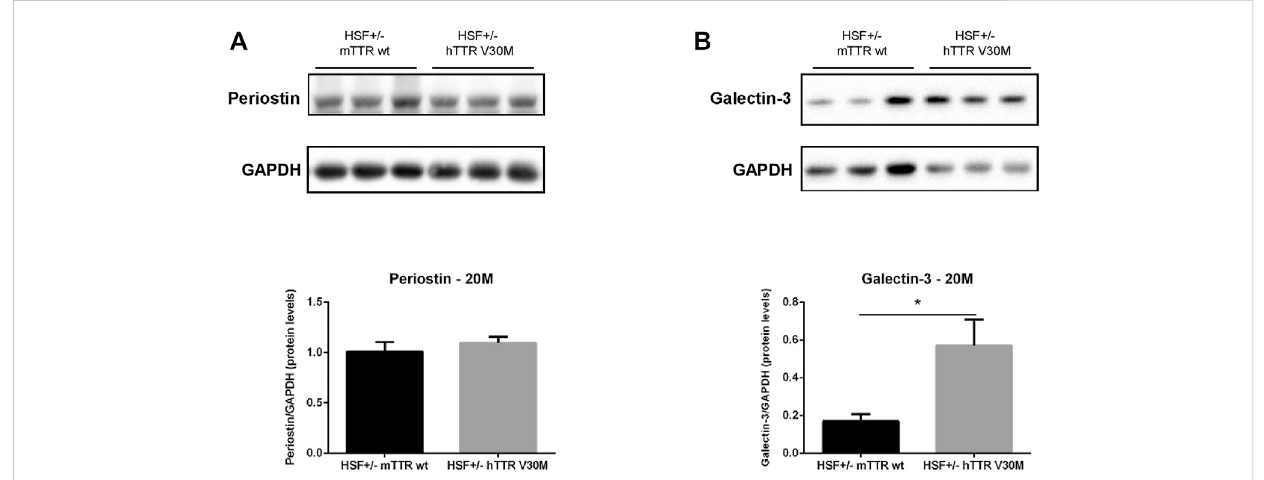
FIGURE 2 Protein levels of relevant matricellular molecules. Representative immunoblot analyses of Periostin (A) , and Galectin-3 (B) . Qualitative results are shown below. n = 6 for each animal group. Error bars, S.E.M. * p <